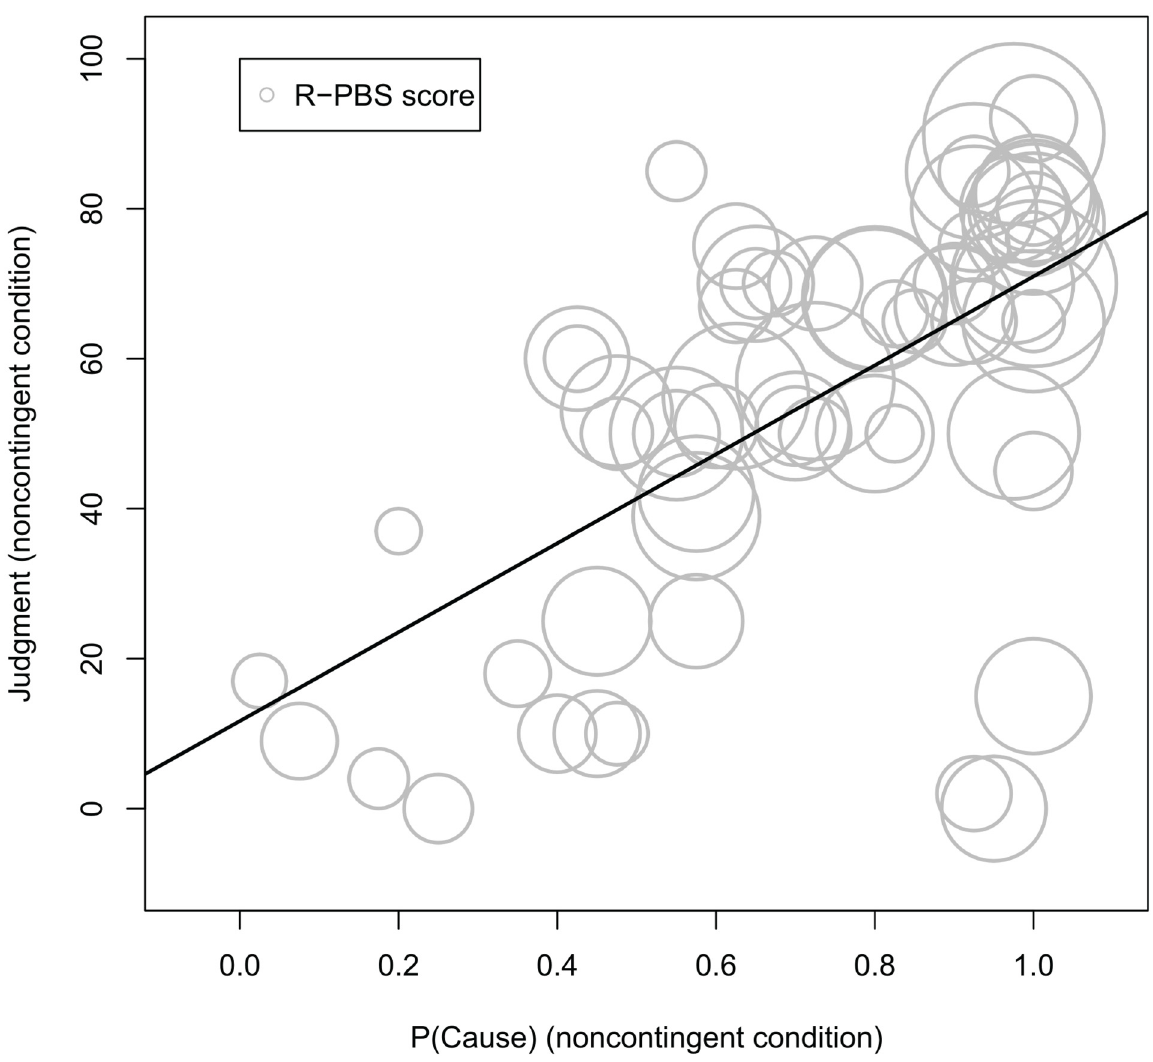
Fig 2. Bubble chart showing the positive relationship between P(Cause) (horizontal axis), Judgments (vertical axis) and R-PBS scores (circle area) in the noncontingent condition. A regression line was fitted to the P(Cause)-Judgments relationship (see main text).